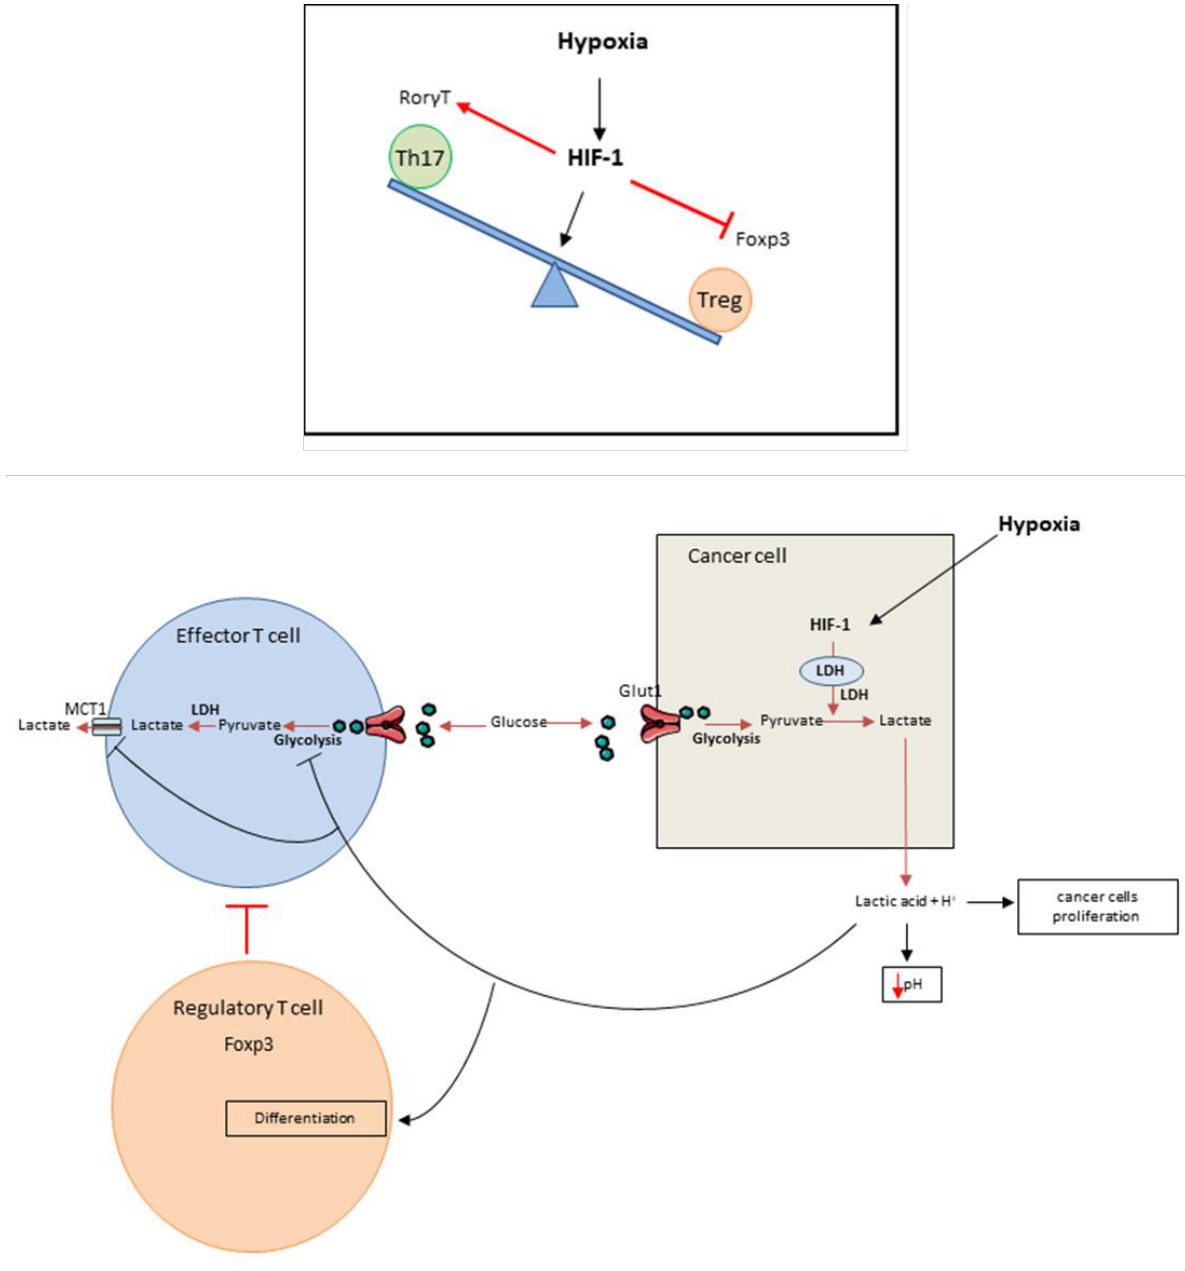
FIGURE 1. Top: Role of hypoxia in Th17/Treg balance disregulation. Hypoxia within the tumors enhances the Th17 development over the Treg development. This is due to the induction of HIF-1 that will in one side promote the expression of RORγt through its cooperation with STAT3 and in the other side bind to Foxp3 inducing its ubiquitination and degradation. Bottom: Hypoxia promotes immunosuppression. Cancer cells have a high glycolytic activity manifested by glucose intake through Glut1 transporter that is metabolized into pyruvate and then into lactic acid through LDH activation induced by HIF-1. The lactic acid is exported within the tumor microenvironment and induces its acidification. Effector T lymphocytes are also dependent of their glycolytic activity and must release lactate by SLC16A1; best known as MCT1. In this context of acidification, MCT1 is inhibited thus blocking the glycolysis and consequently the activation of the effector T cells. Moreover the high lactate concentration within the tumor microenvironment will promote Treg biology by inducing FoxP3 expression. In these conditions hypoxia leads to immunosuppression through the activation or inhibition of different immune cells